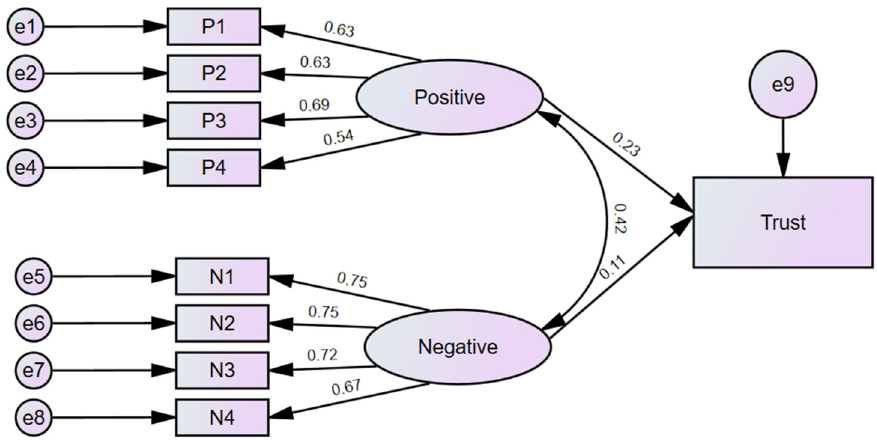
Figure 3. Structural equation model with standardized estimates.